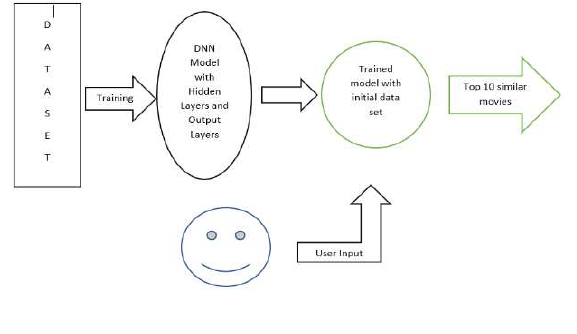
Fig 3. Implementation